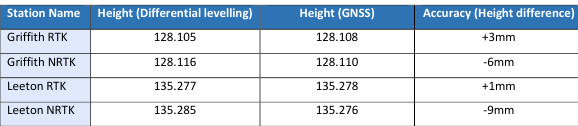
Table 3 : Accuracy, difference from true height